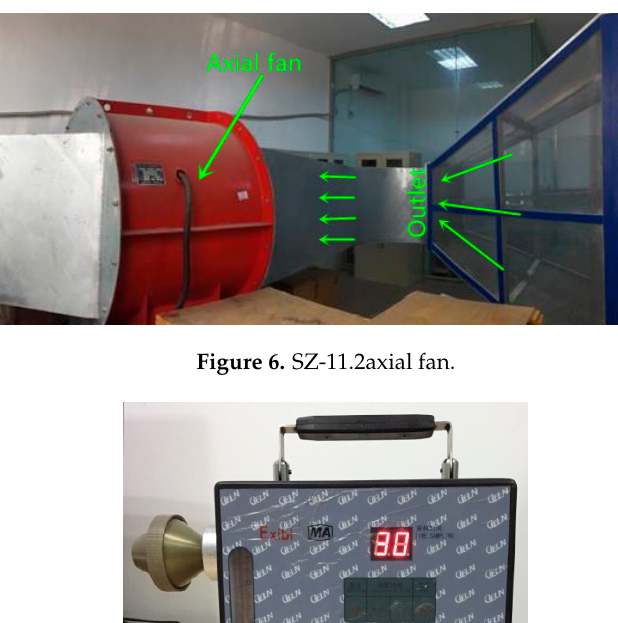
Figure 5. Air tunnel simulation apparatus.